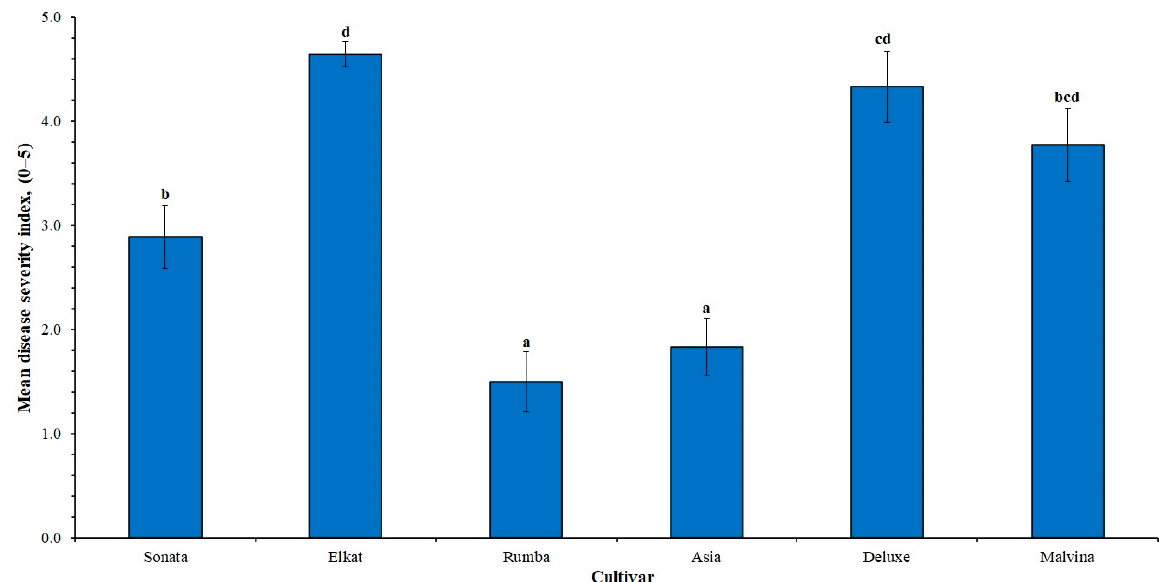
Figure 3. The susceptibility of different strawberry cultivars inoculated by C. acutatum. Means followed by the same letter did not differ significantly ( p <